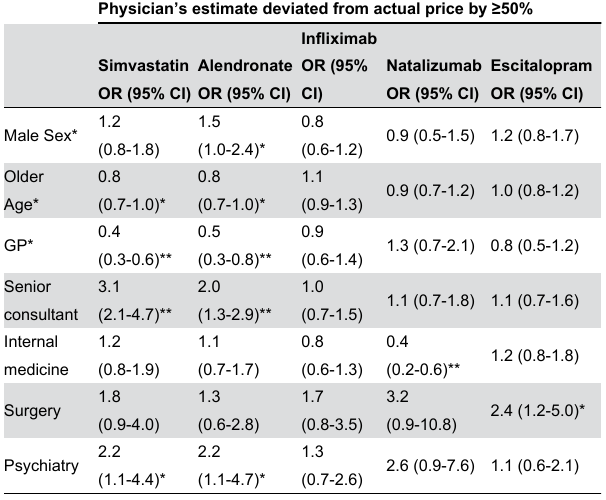
Table 4. Demographic characteristics and medical specialty as explicators for estimates deviating from actual price